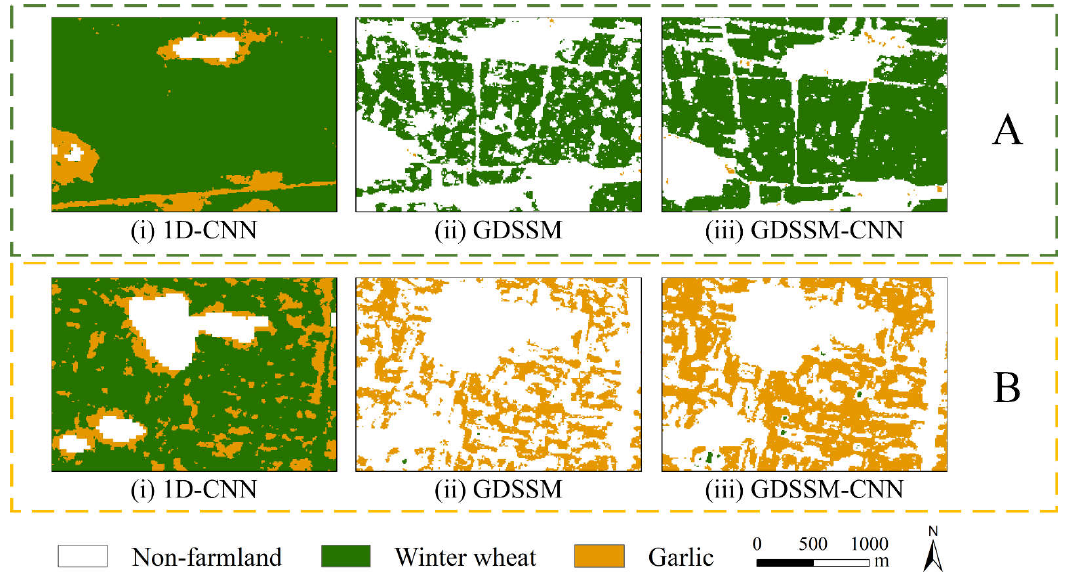
Figure 9. Comparison between crop discrimination results using (i) 1D-CNN, (ii) GDSSM and (iii) GDSSM-CNN in areas ( A , B ).